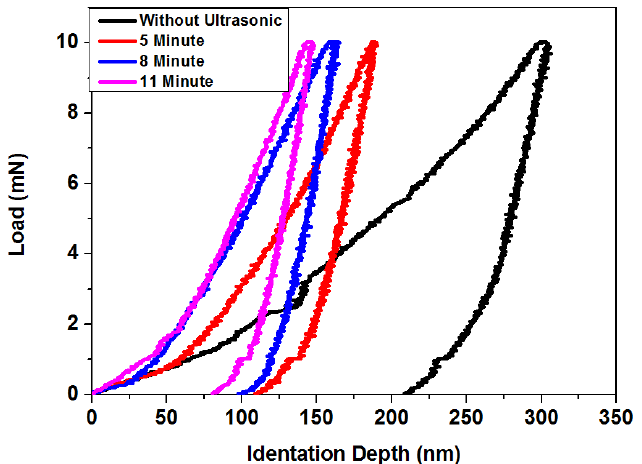
Figure 4. Effect of ultrasonic treatment on TiN coating thickness at 16 kHz for different exposure times.